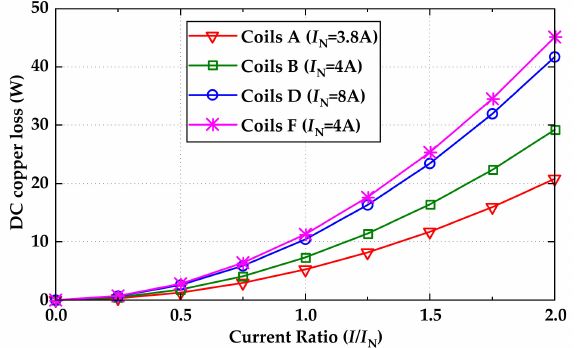
Figure 12. DC copper loss of coreless stator with different coil types under different phase